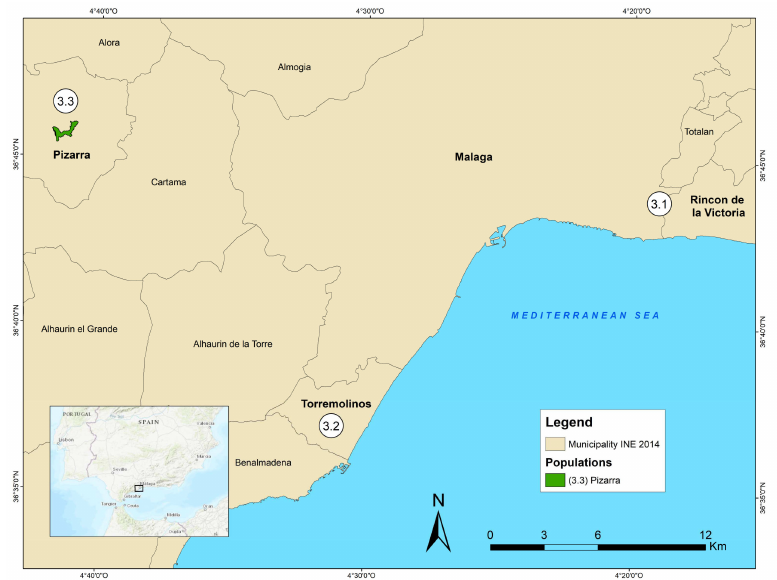
Figure 2. Westernmost-Iberian nucleus of the 5220* HCI. 3.1 and 3.2 non-mapped localities in REDIAM, M á laga–Rinc ó n de la Victoria, and Torremolinos, respectively. 3.3. Pizarra locality mapped by REDIAM (2021) [4]. The municipality is obtained from the Spanish National Geographic Institute